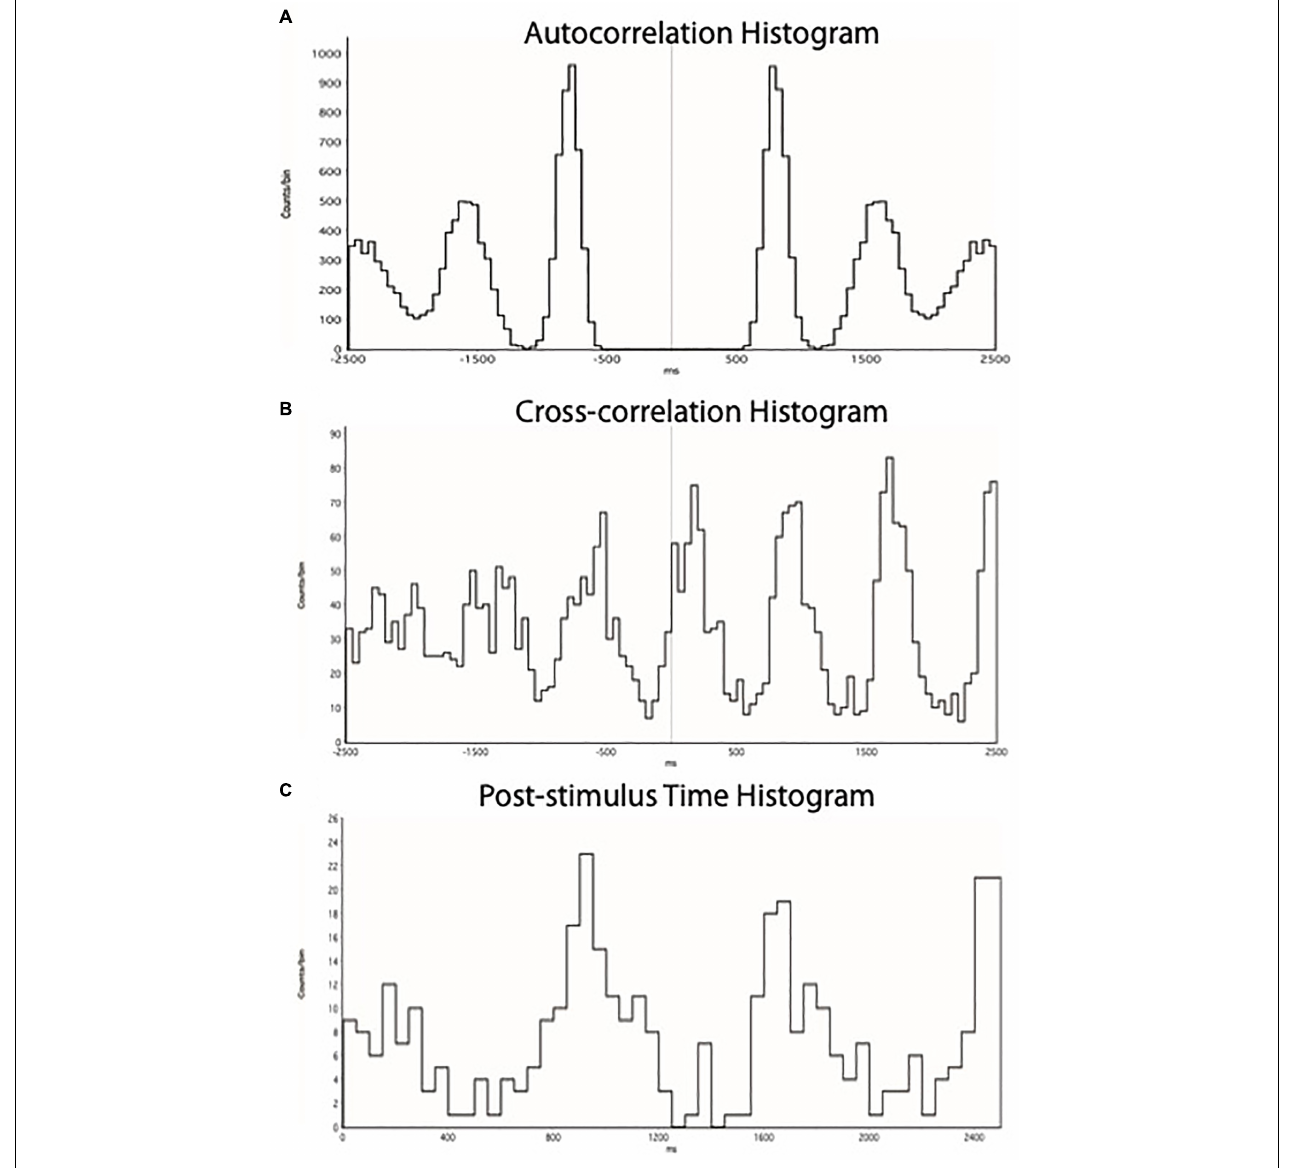
FIGURE 2 | (A) ECG autocorrelation histogram, showing times of occurrence of 5 cycles of R-waves. (B) Cross-correlation histogram between MSNA and ECG, showing times of occurrence of sympathetic spikes as a function of the 5 cycles of R-waves shown in (A) . (C) Post-stimulus time histogram, showing the times of occurrence of sympathetic spikes relative to the triggering R-wave. Each set of histograms was generated for each specific epoch of the recording to discriminate cardiac-locked negative-going sympathetic spikes from the raw